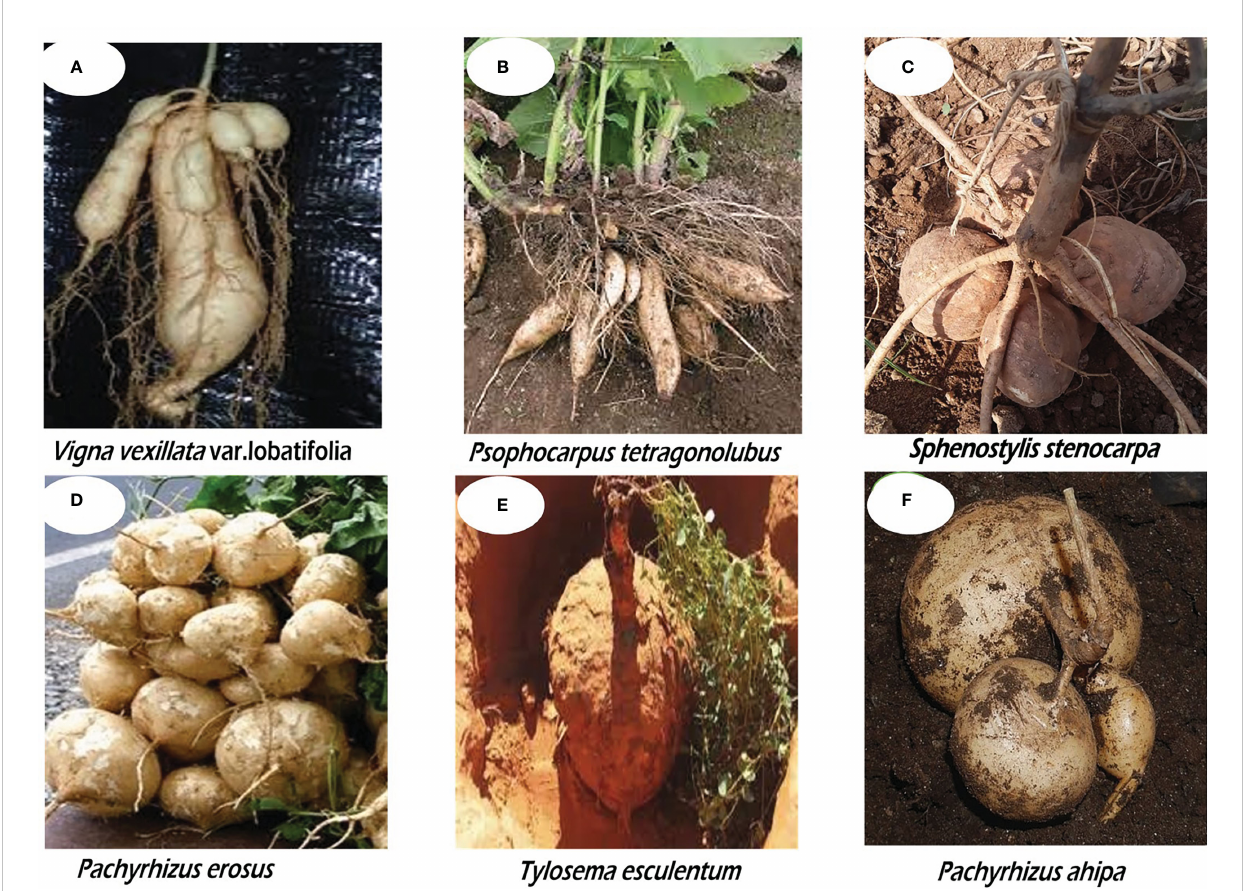
FIGURE 1 Different tuber shapes and sizes of some underutilized legumes: (A) Zombi pea ( Vigna vexillata ), (B) Winged bean ( Psophocarpus tetragonolobus ), (C) African yam bean ( Sphenostylis stenocarpa ), (D) Mexican yam bean ( Pachyrhizus erosus ), (E) Marama bean ( Tylosema esculentum ), (F) Ahipa ( Pachyrhizus aphipa